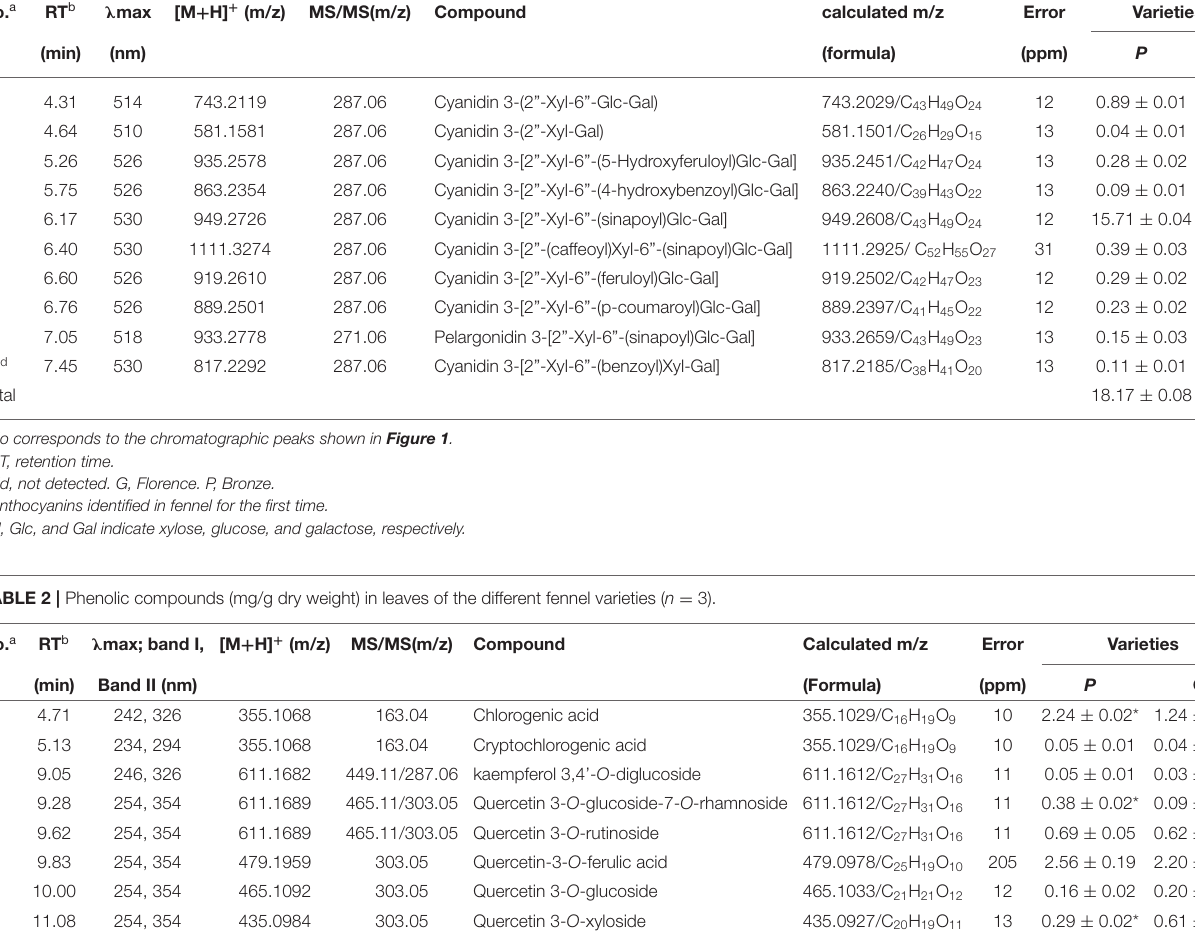
TABLE 1 | Anthocyanin levels (mg/g dry weight) in leaves of the different fennel varieties ( n = 3). No. a RT b